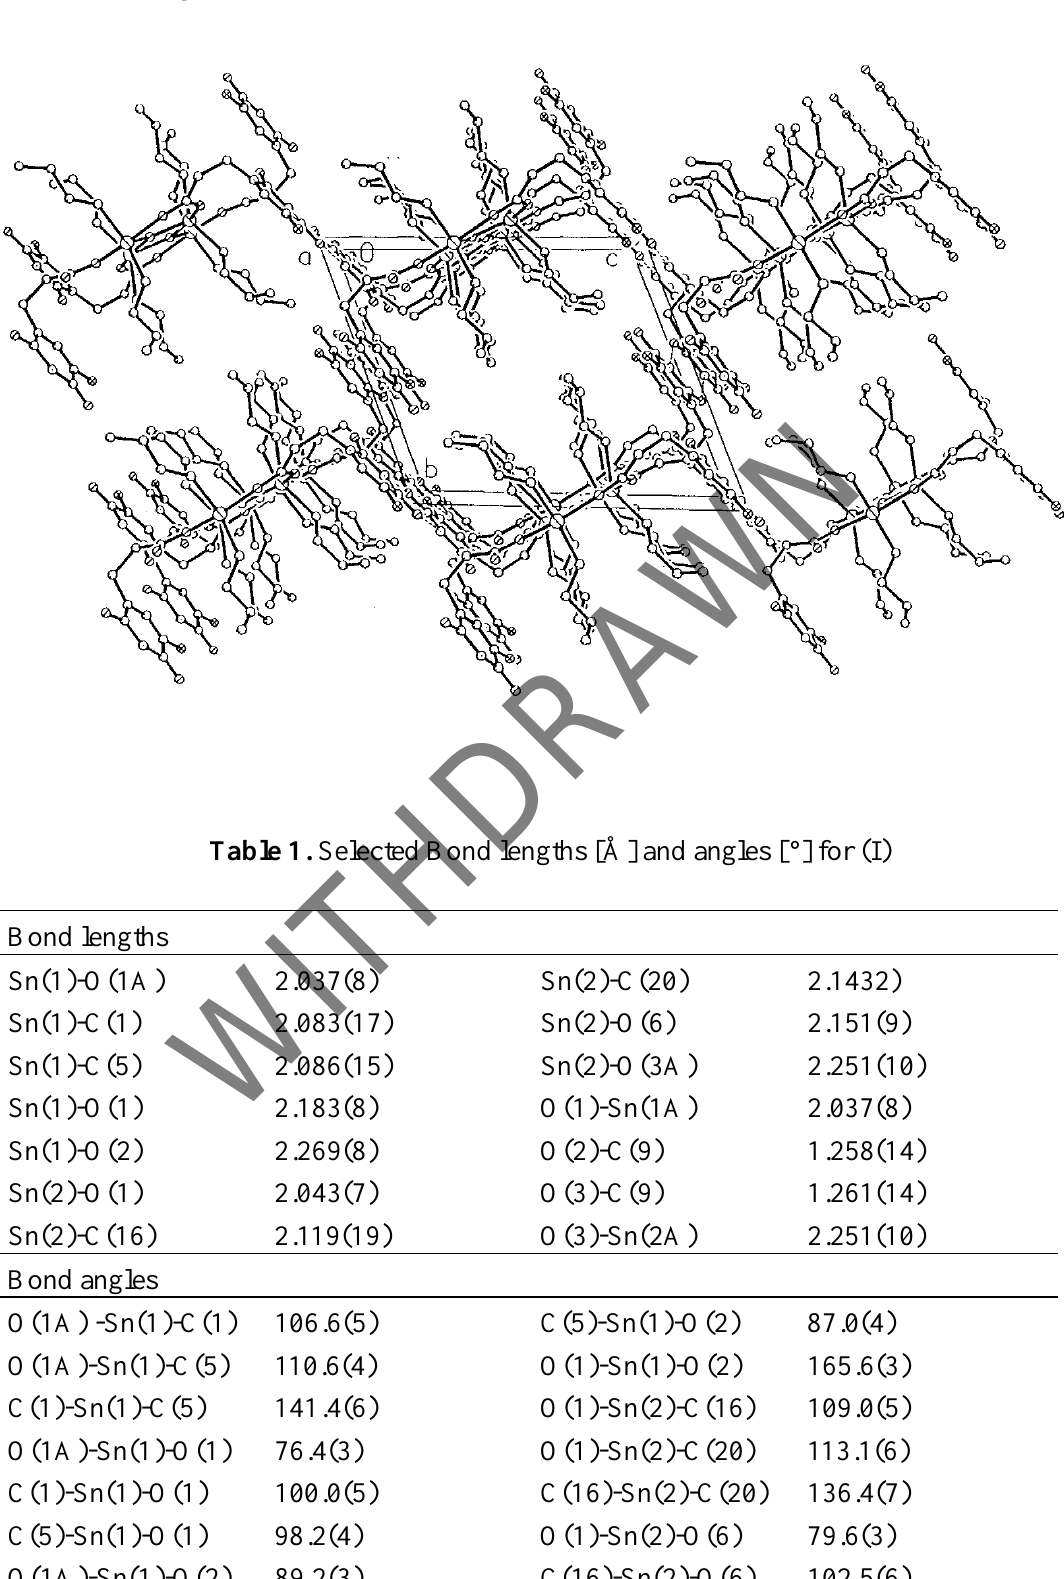
Table 1. Selected Bond lengths [Å] and angles [°] for